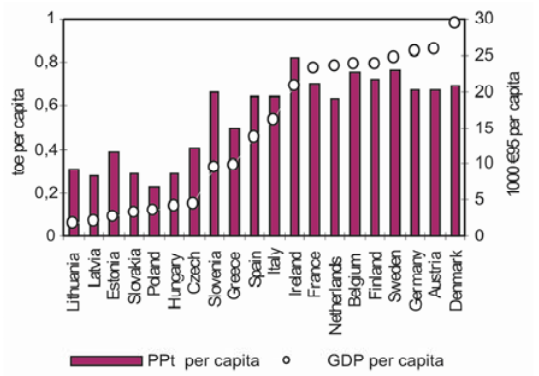
Fig 7. Relative consumption of petroleum products in road transport and GDP per capita for different countries